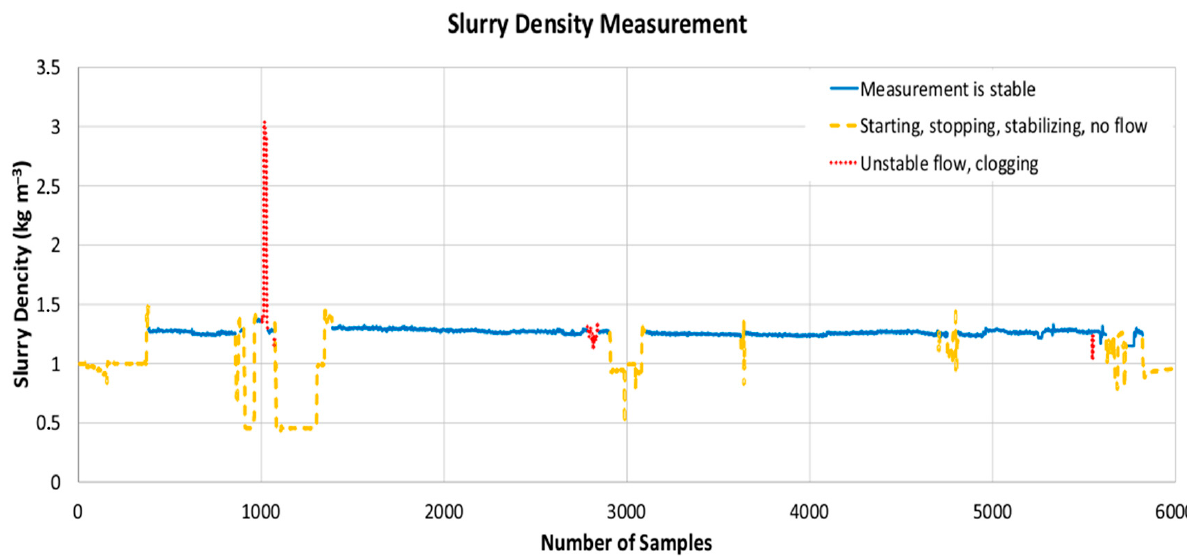
Figure 5. Results of the sediment measurements with the use of the hydraulic densimeter.